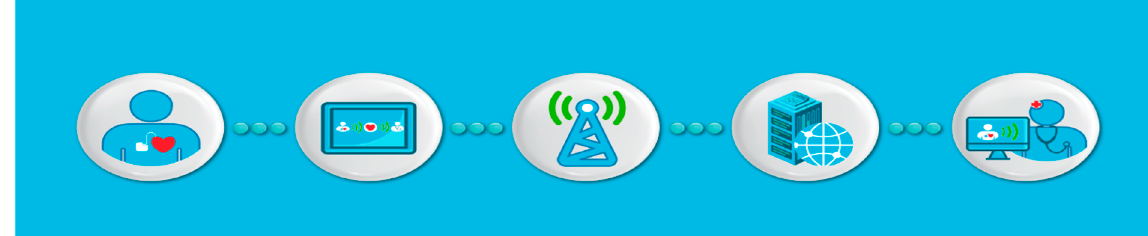
Figure 1. Schematic drawing of the circuit consisting of patient with CIED, transmitter, server, and hospital computer and staff.